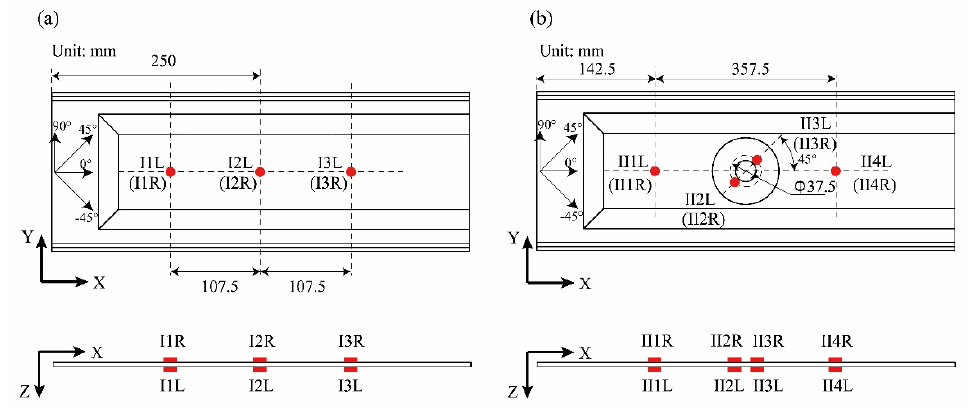
Figure 3. Arrangement of the resistance strain gauges in monitoring the loading responses of the PWF composite beams: ( a ) strain gauges in the BW-I specimens; ( b ) strain gauges in the BW-II specimens.